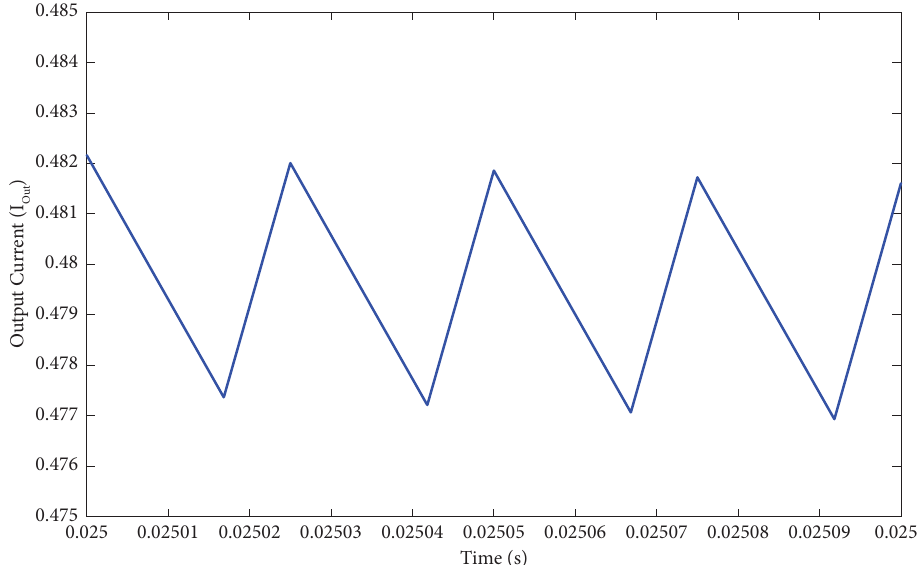
Figure 8: Te simulation result of output current with an average value of